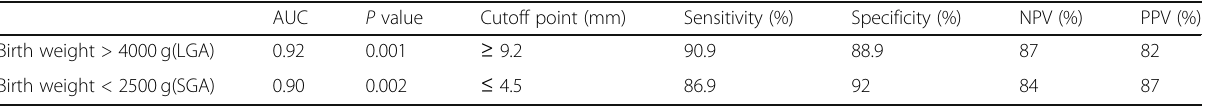
Table 3 Sensitivity and specificity of FASTT as a predictor of birth weight > 4000 g and birth weight < 2500 g AUC P value Cutoff point